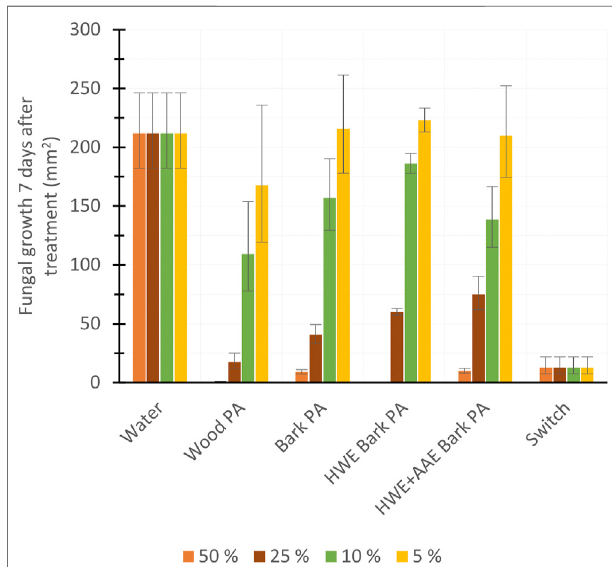
FIGURE 8 | Fungicide potency of pyroligneous acids (PAs) produced from aspen tree wood, bark, or variously extracted bark ( HWE , hot water extraction; AAE , alkaline alcohol extraction), commercial herbicide (Switch), or water measured via the inhibition of fungal ( Fusarium culmorum ) growth 7 days after the treatments (mean ± SD), n = 4.